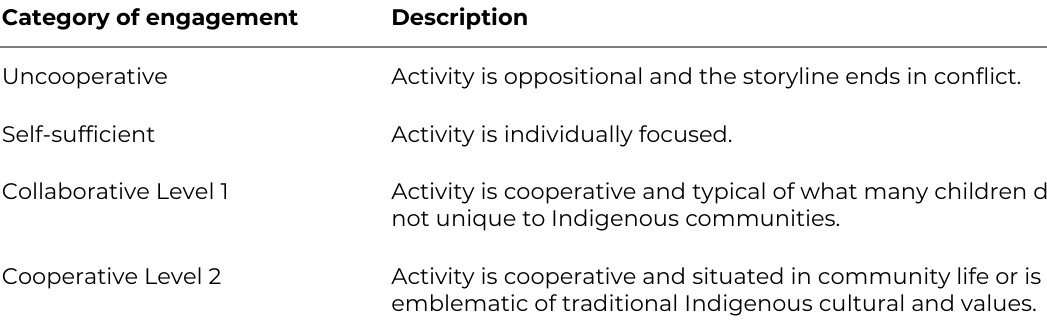
Table 4: Categories of collaborative activity Category of